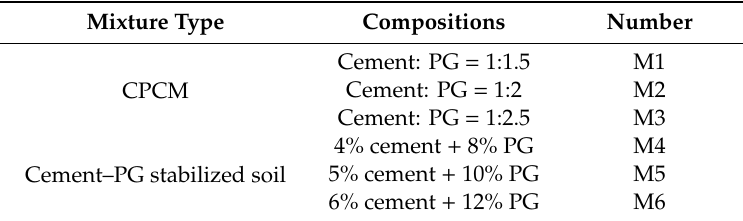
Table 5. Mix compositions and mix numbers of cementitious material and cement-stabilized soil. PG: Phosphogypsum; CPCM: Cement–PG cementitious